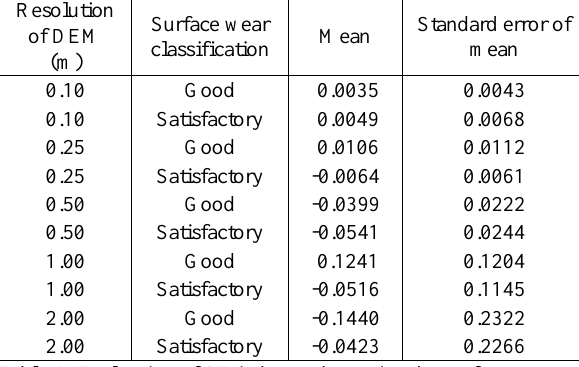
Table 2. Evaluation of SE index to determine the surface wear condition.